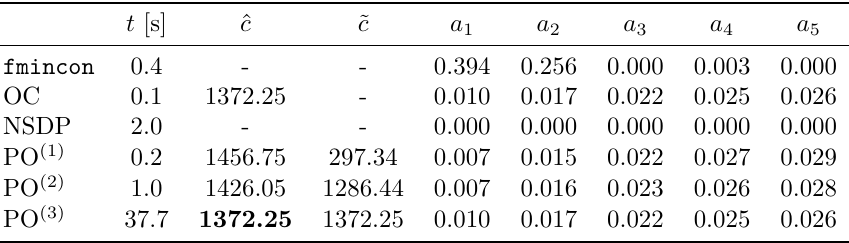
Table 3. Comparison of the four optimization approaches on the design of the girder beam problem. Bold text denotes the proven global